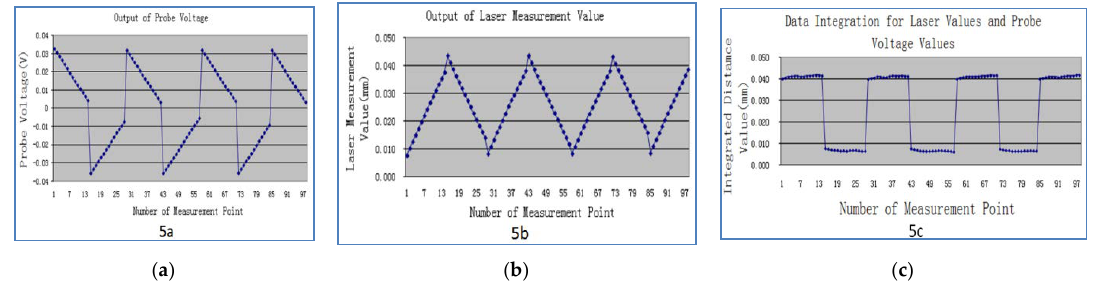
Figure 5. Signal synthetic diagram of probe voltage and displacement of laser interferometer: ( a ) the sampled voltage value via AD card after triggering during measurement; ( b ) the sampled laser value after triggering ; ( c ) the combined value of laser value and voltage value obtained by synchronous sampling after triggering.